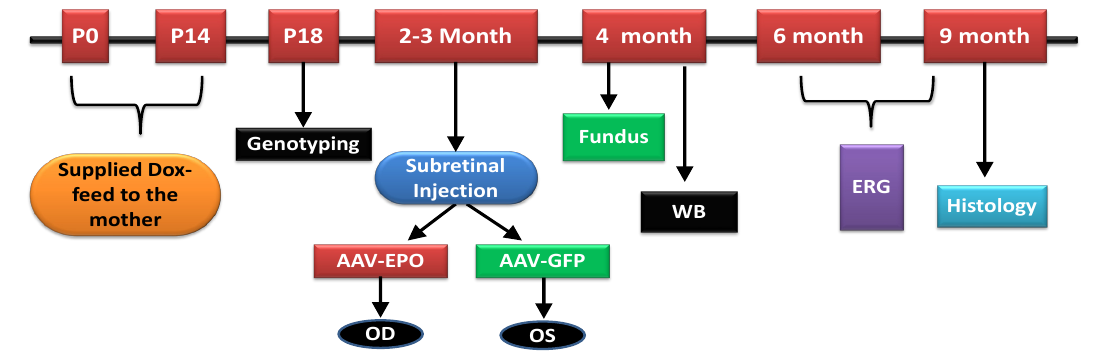
Figure 1. Experimental design.